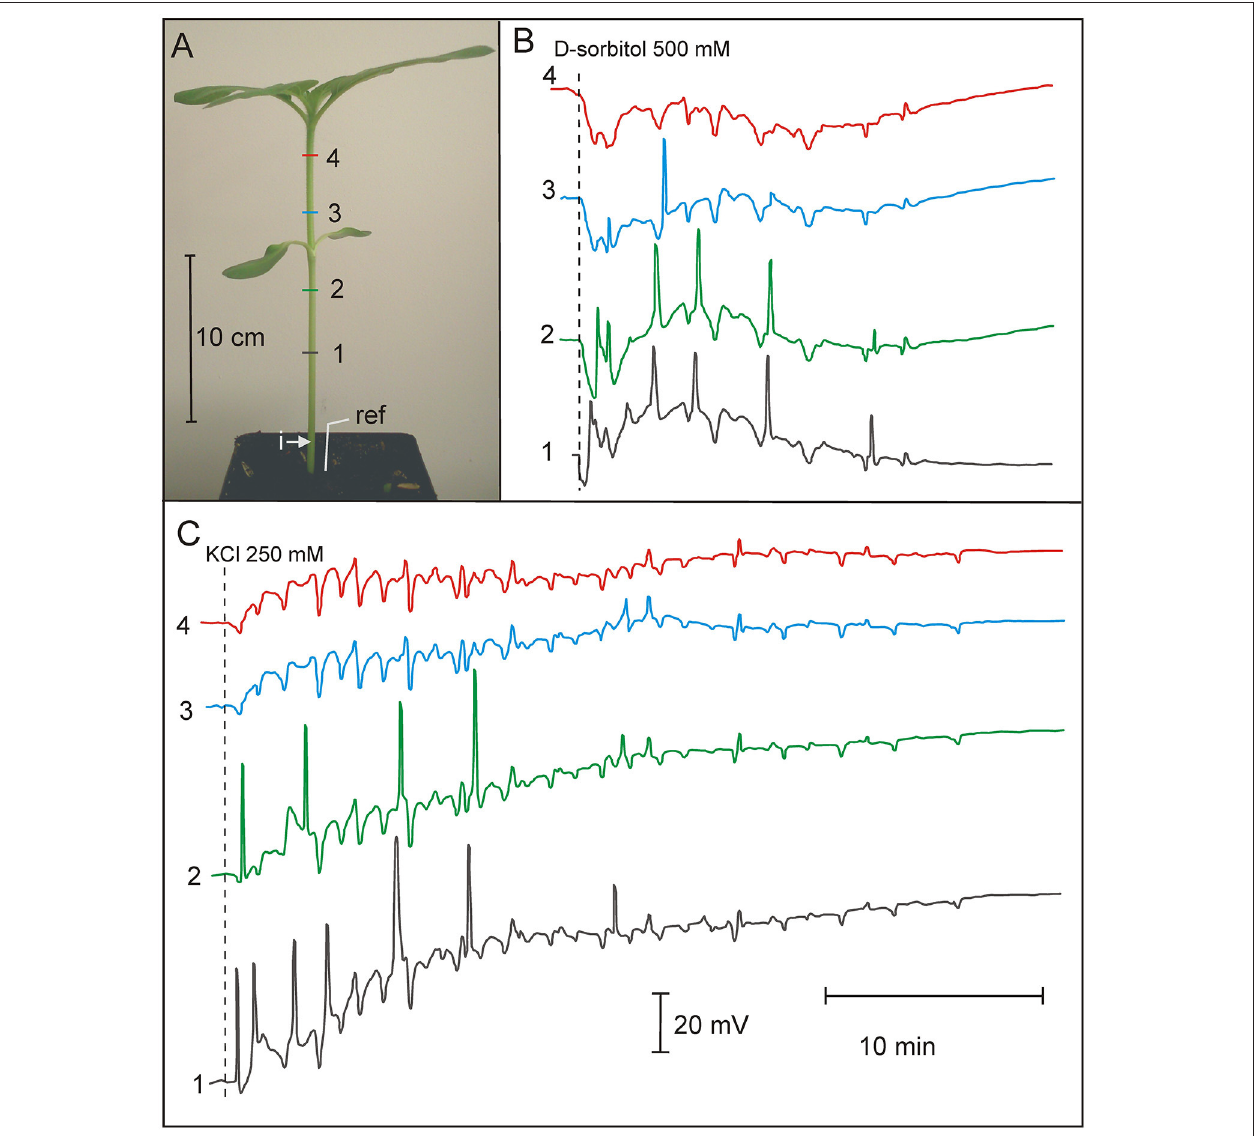
FIGURE 3 | Osmotically and potassium chloride-induced series of action potentials in 3-week old Helianthus annuus . (A) Helianthus annuus plants, electrode arrangement (1, 2, 3, 4, ref—reference electrode) and site of solution injection (i). (B) Example of recordings of action potential series after D-sorbitol 500 mOsm (500mM) injection into the stem base. (C) Example of recordings of action potential series after KCl 500 mOsm (250mM) injection into the stem base. Data details are presented in Table 3